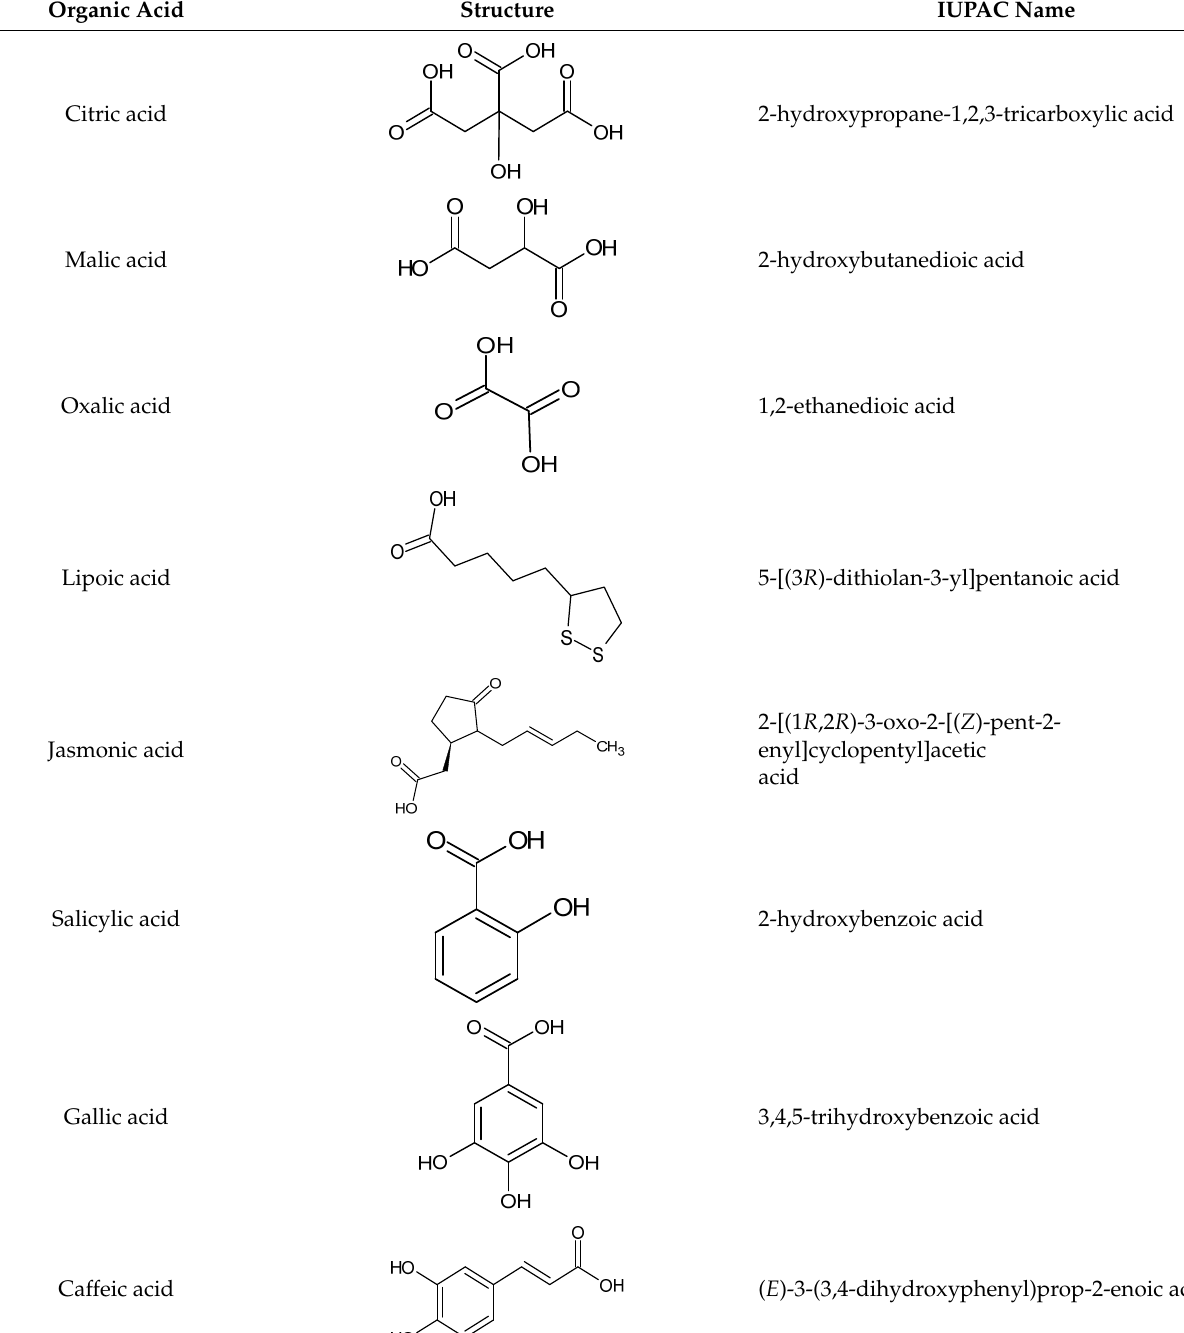
Table 1. The chemical structures of organic acids presented in this review.